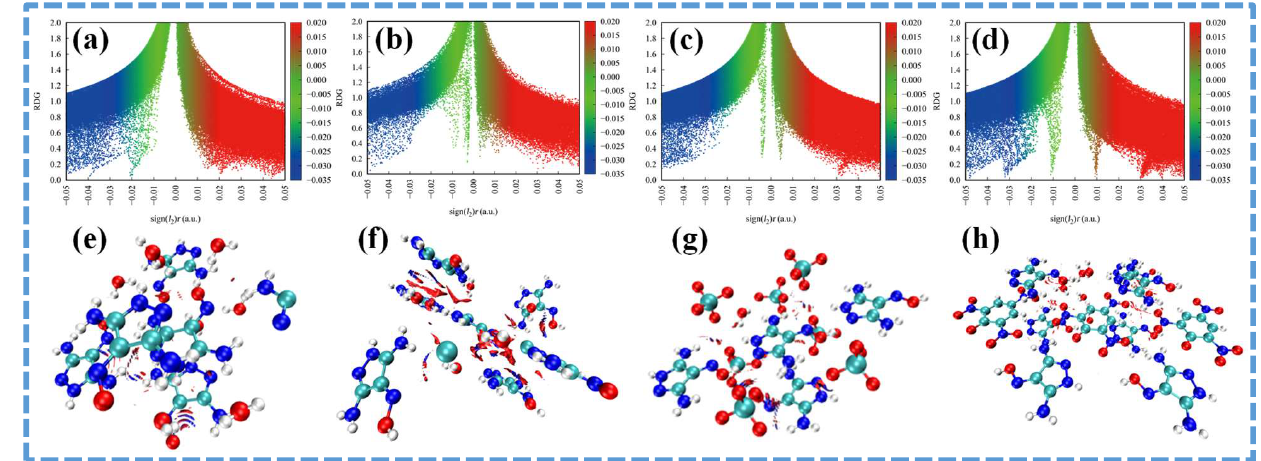
Figure 6. RDG map ( a–d ) and NCI analysis ( e–h ) for crystals DAPO·2H 2 O, DAPOC·H 2 O, DAPOP·H 2 O, and DAPOT·3H 2 O, respectively.